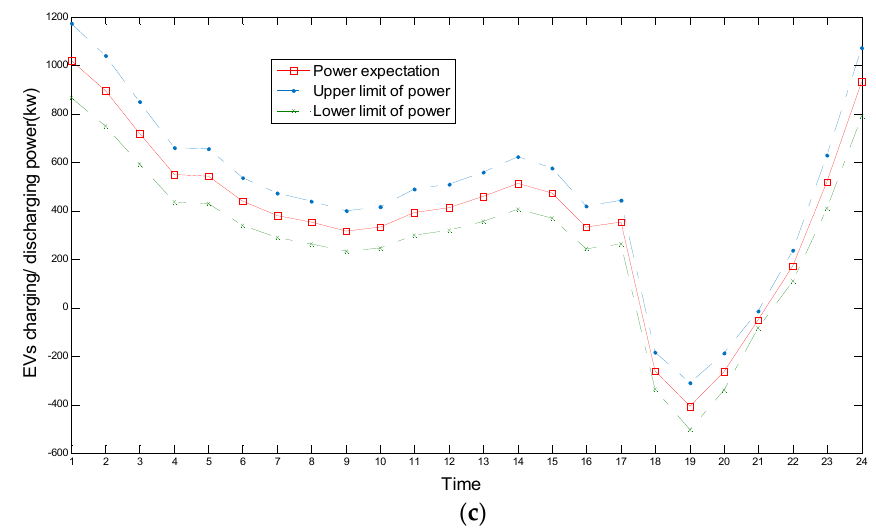
Figure 5. The charging/ discharging load profiles of 1000 EVs. ( a ) Case 2; ( b ) Case 3; ( c ) Case 4.